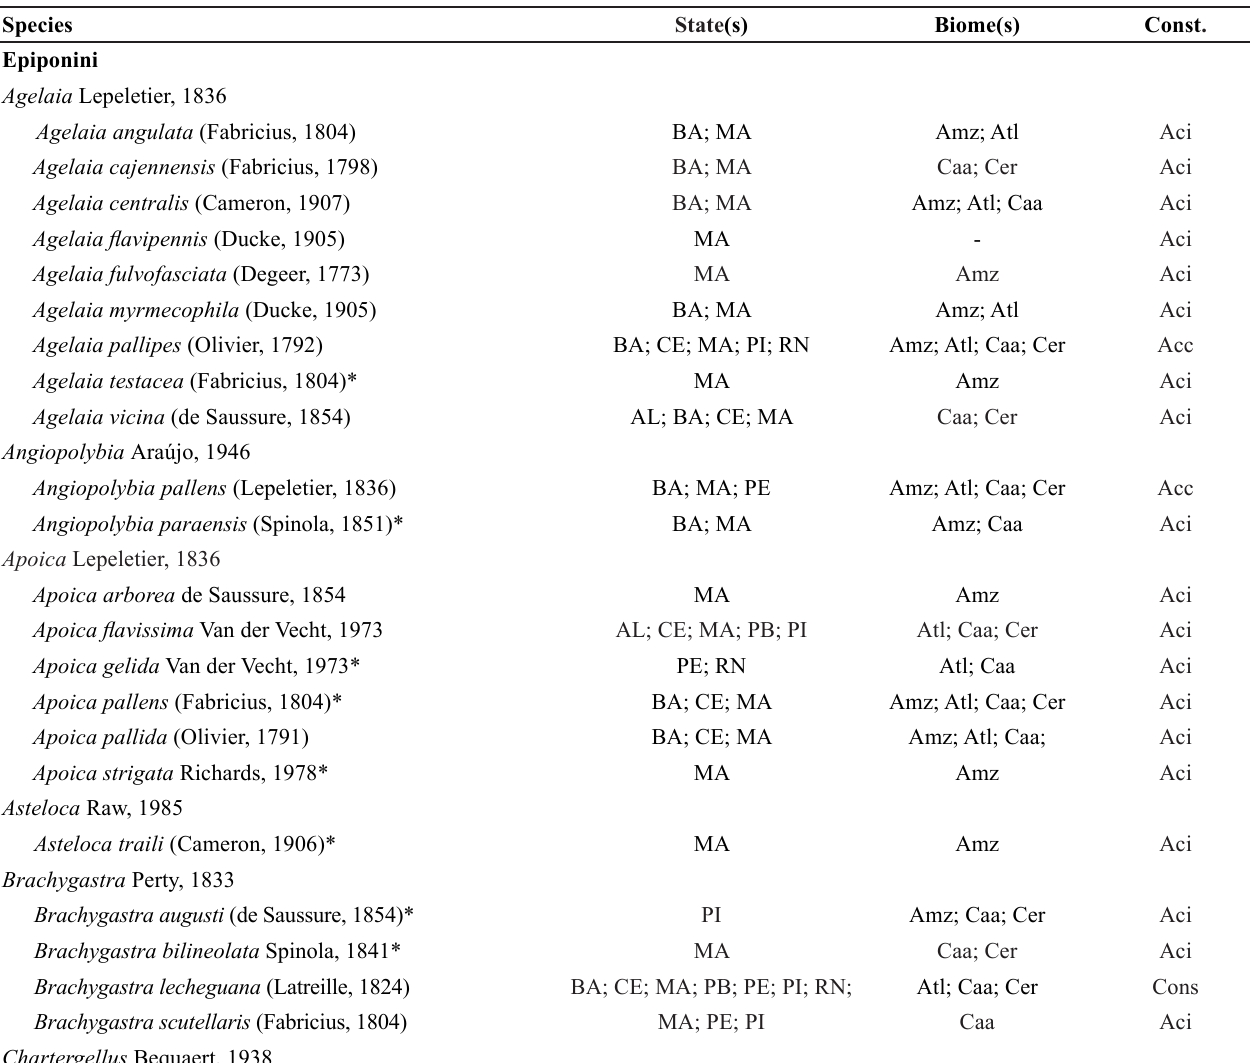
Table 2 . Species of Social Wasps registered in Northeastern Brazil. States: AL: Alagoas; BA: Bahia; CE: Ceará; MA: Maranhão, PB: Paraí- ba; PE: Pernambuco; PI: Piauí; RN: Rio Grande do Norte. Biomes: Atl: Atlantic Forest; Amz: Amazon Forest; Caa: Caatinga; Cer: Cerrado. Constance: Acc: Accessory; Aci: Accidental; Cons: Constant. *New species records after Richards